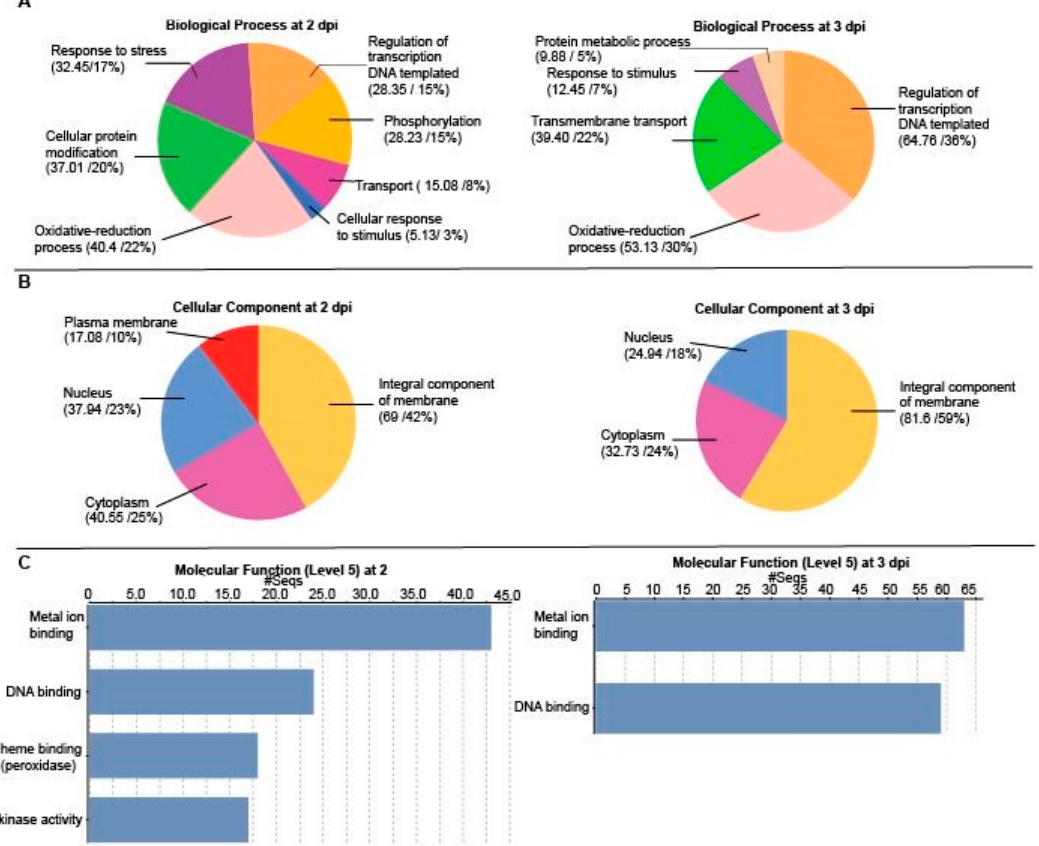
Figure 2. Summary pie charts and bar charts of GO analysis of DEGs that are upregulated transcripts at 2 and 3 dpi. The charts show the distribution of sequences according to the level 5 GO terms affiliated with ( A ) biological processes, ( B ) cellular components, and ( C ) molecular functions. The numbers and percentages of sequences are presented in parentheses with each slice in the pie charts.